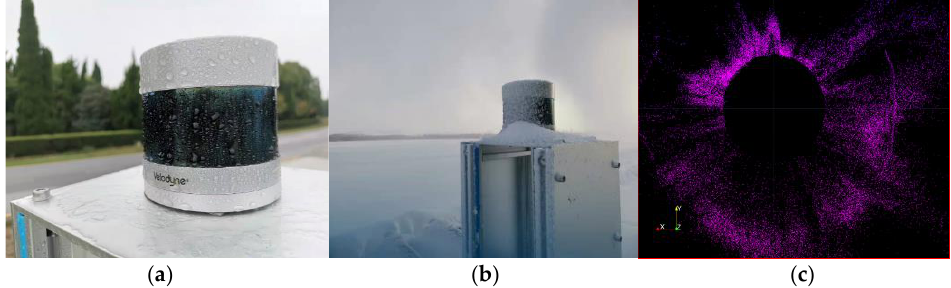
Figure 8. LiDAR operating in rain and snow and its output point cloud. ( a ) Under rain. ( b ) Under snow. ( c ) Point cloud under snow.